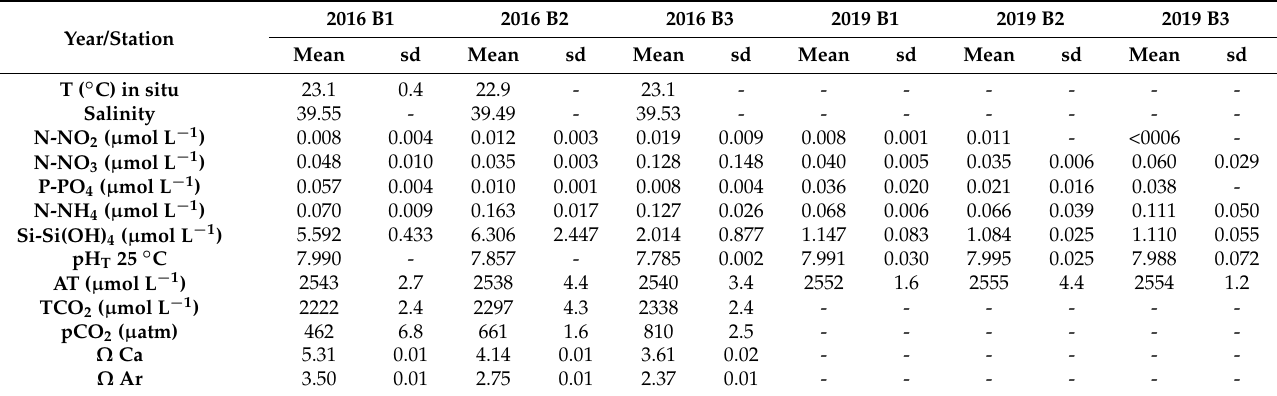
Table 1. Physico-chemical variables measured along the Bottaro crater OA gradient in 2016 (27 September) and in 2019 (26 September). In 2018 (20 September), only the pH NBS 25 ◦ C